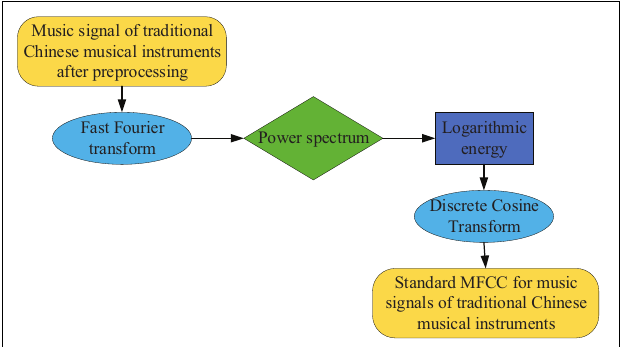
FIGURE 4 | The standard MFCC parameter extraction process for traditional instrumental music.